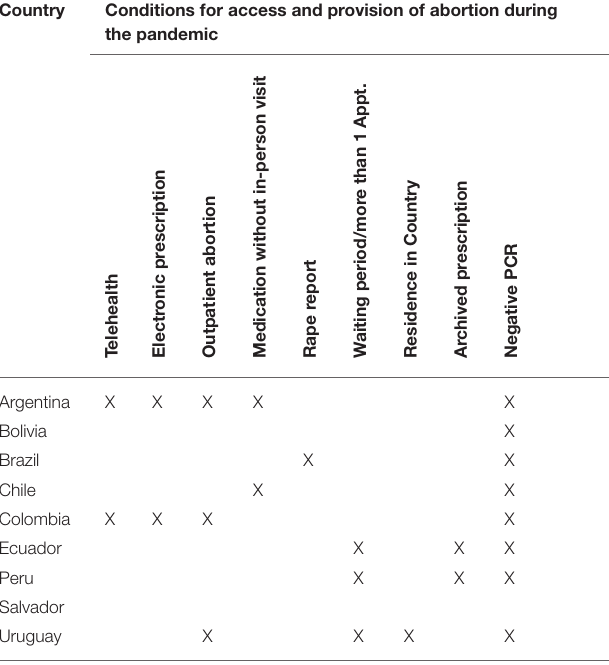
TABLE 8 | Conditions for access and provision of abortion services during the first year of the COVID-19 pandemic.